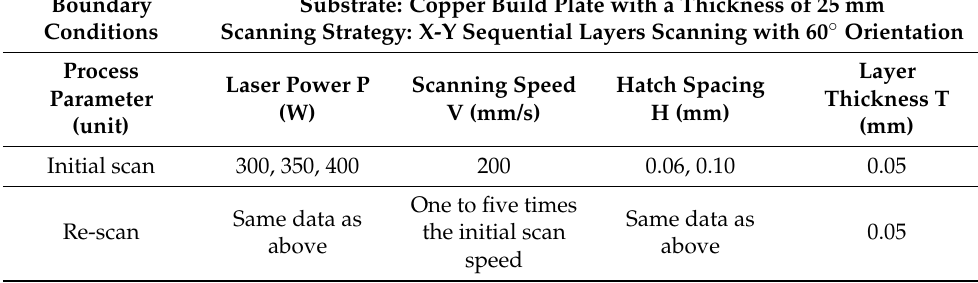
Table 3. Process conditions for the